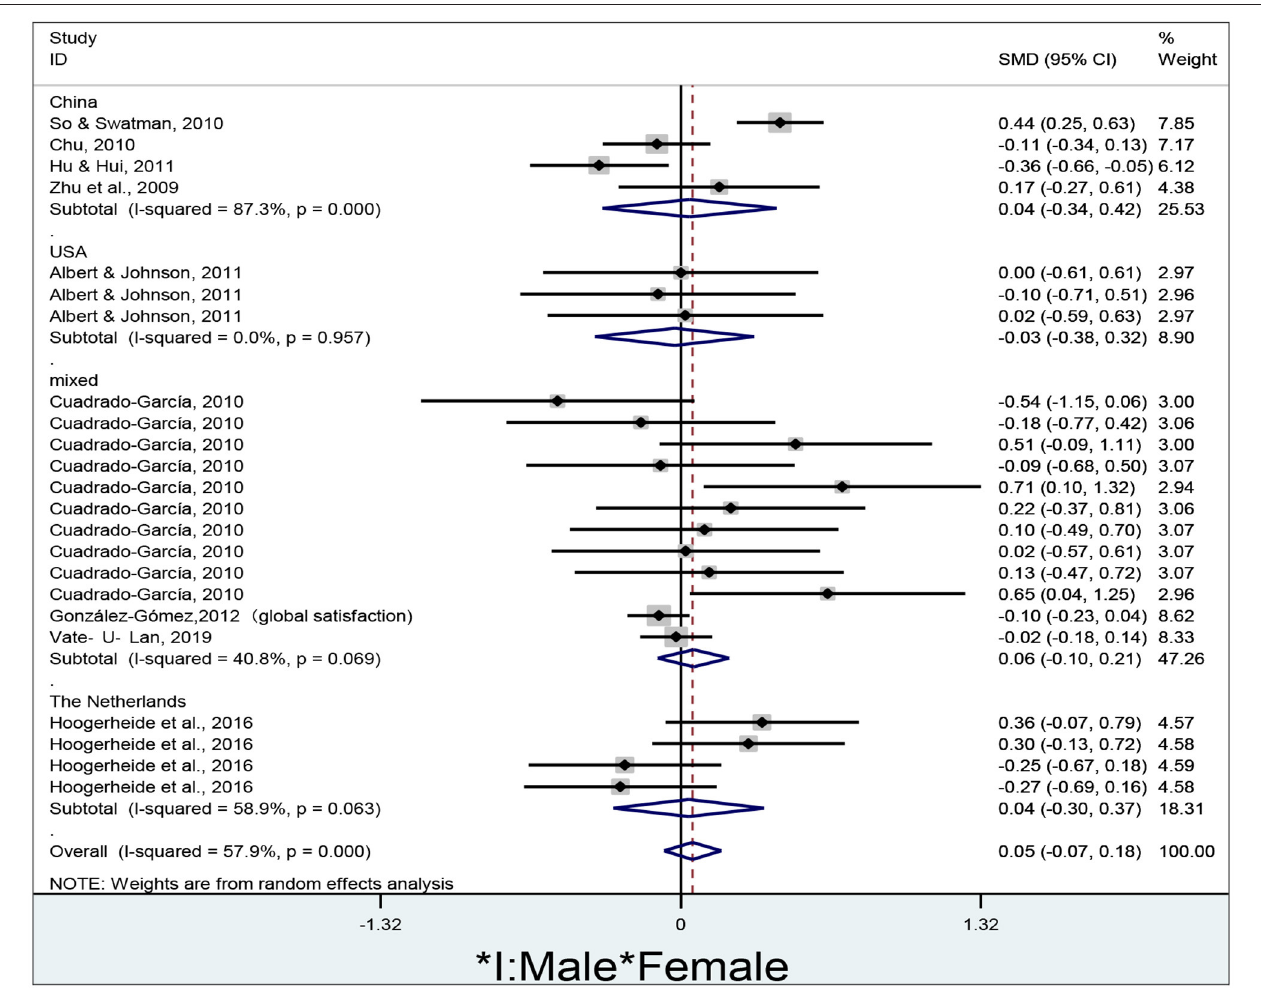
FIGURE 6 | Gender differences in e-learners’ satisfaction in different